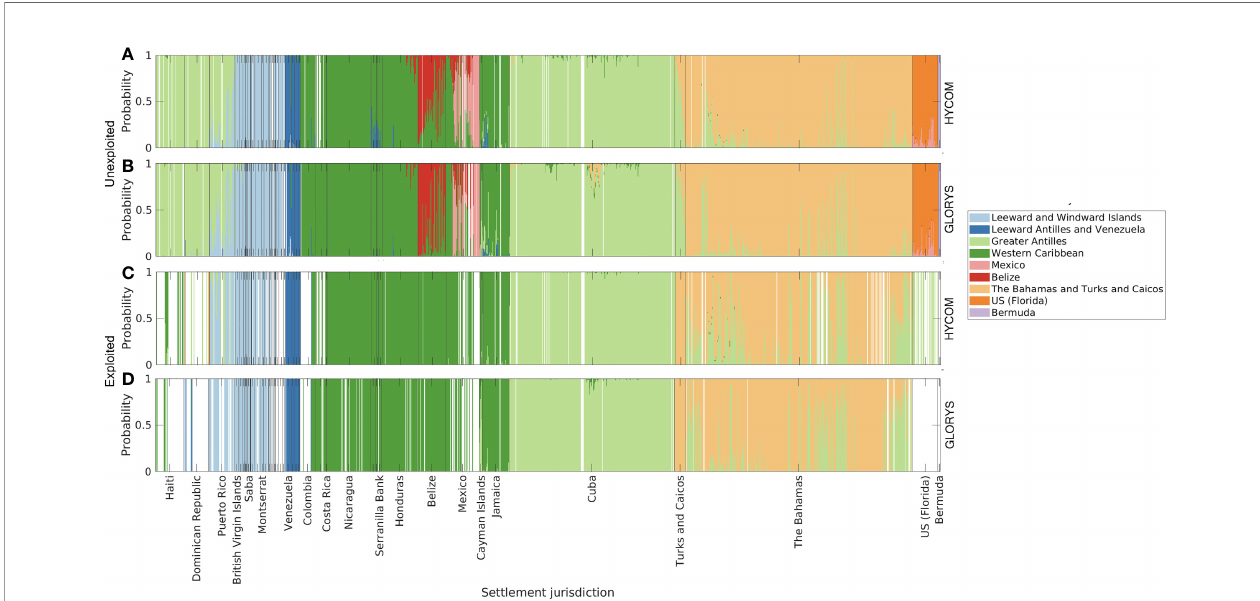
FIGURE 8 | Origin of larvae per settlement polygon, for two different reproductive output scenarios: 1) unexploited, i.e. , spawning uniform for all habitat polygons (A, B) ; and 2) contemporary (exploited), with spawning scaled by median adult densities reported per jurisdiction (C, D) . Larvae dispersed with HYCOM (A, C) , and GLORYS12v1 (B, D) velocities. Origin areas are relative to genetic divisions identi fi ed by Truelove et al.,